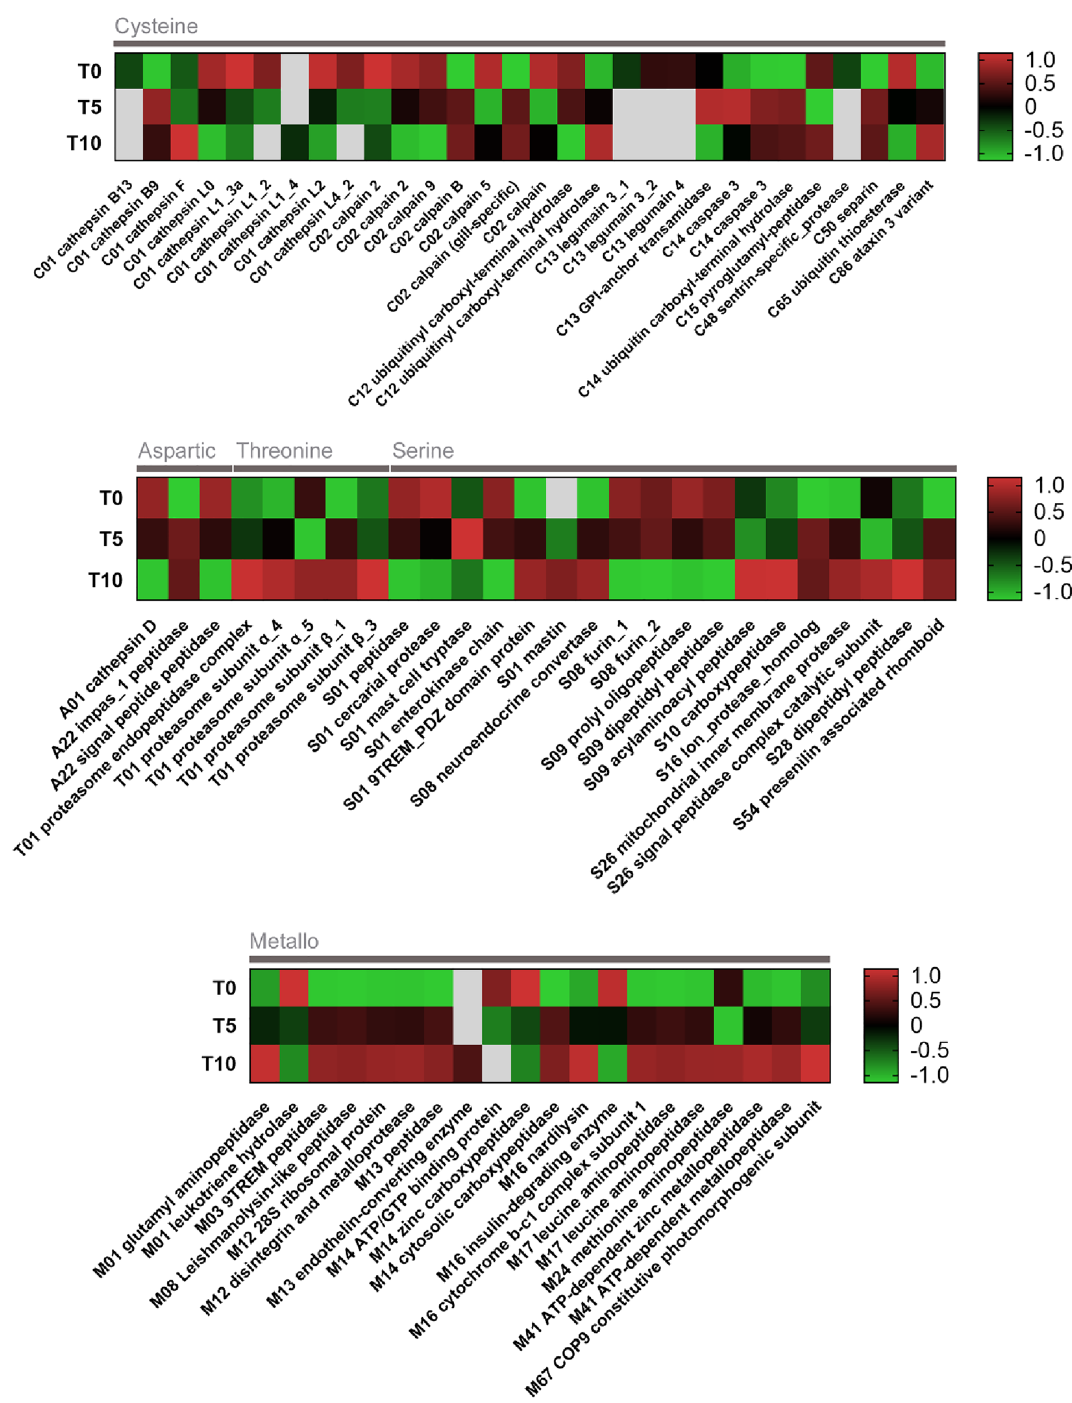
Figure 7. Expression dynamics of genes coding peptidases in F. hepatica eggs at different points of development. The heat maps show statistically significant changes in RNA levels of differentially expressed genes at a single gene resolution. Genes which are not expressed at a particular time point are coloured in grey. Differences in expression levels are shown as Z-score values. Gene names shown at x-axis begin with the peptidase family code; catalytic classes of peptidases are shown above the